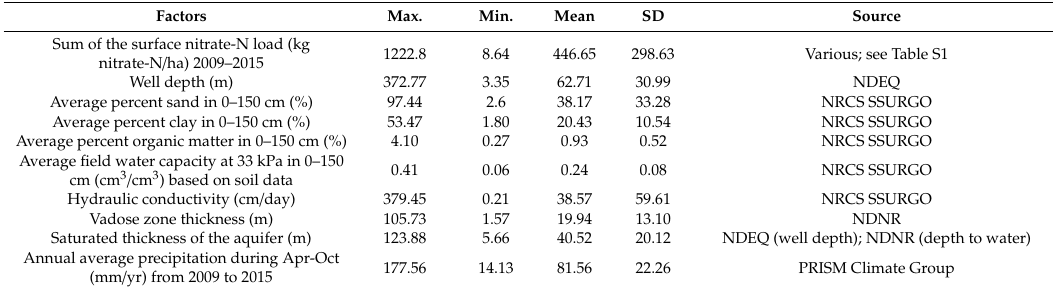
Table 1. Covariates used in fitting the nitrate contamination model. Factors